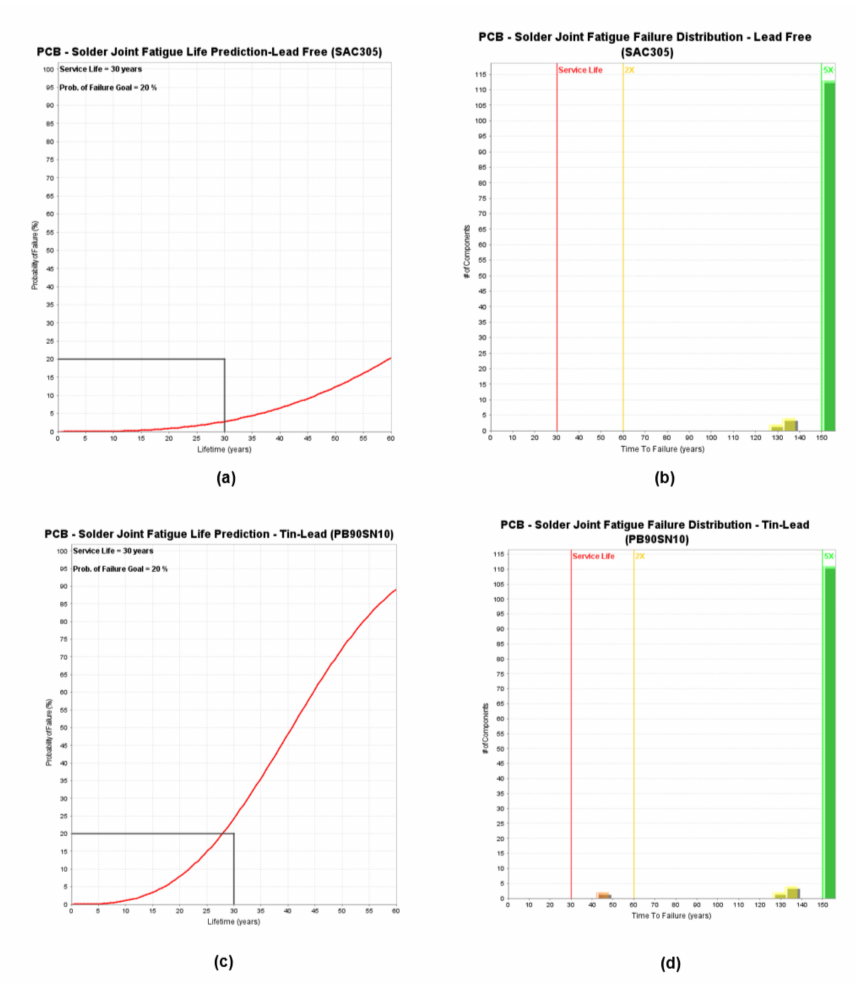
Figure 16. ( a ). Solder joint fatigue life prediction for SAC305 lead-free solder ( b ). Fatigue failure distribution for SAC305 lead-free solder ( c ). Solder joint fatigue life prediction for PB90SN10 lead solder. ( d ). Fatigue failure distribution for PB90SN10 lead